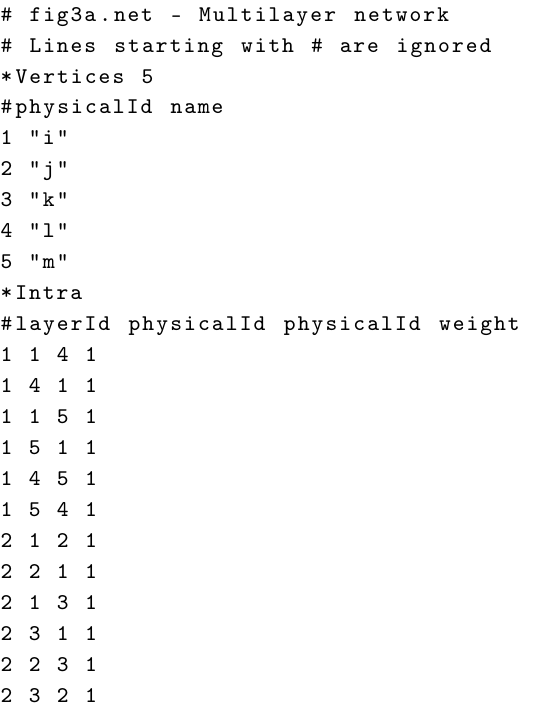
# fig3a.net - Multilayer